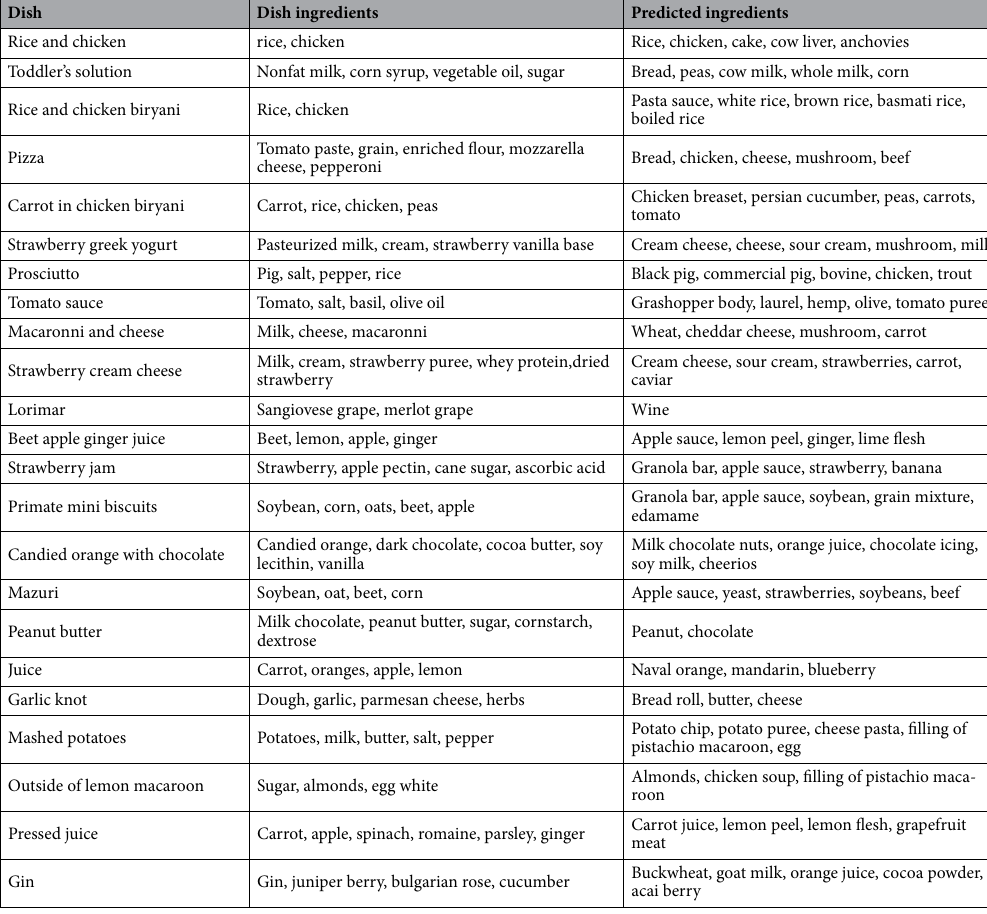
Table 1. Results of applying MetDecomposer to complex foods in Global FoodOmics database. For each dish, five top raw ingredients are